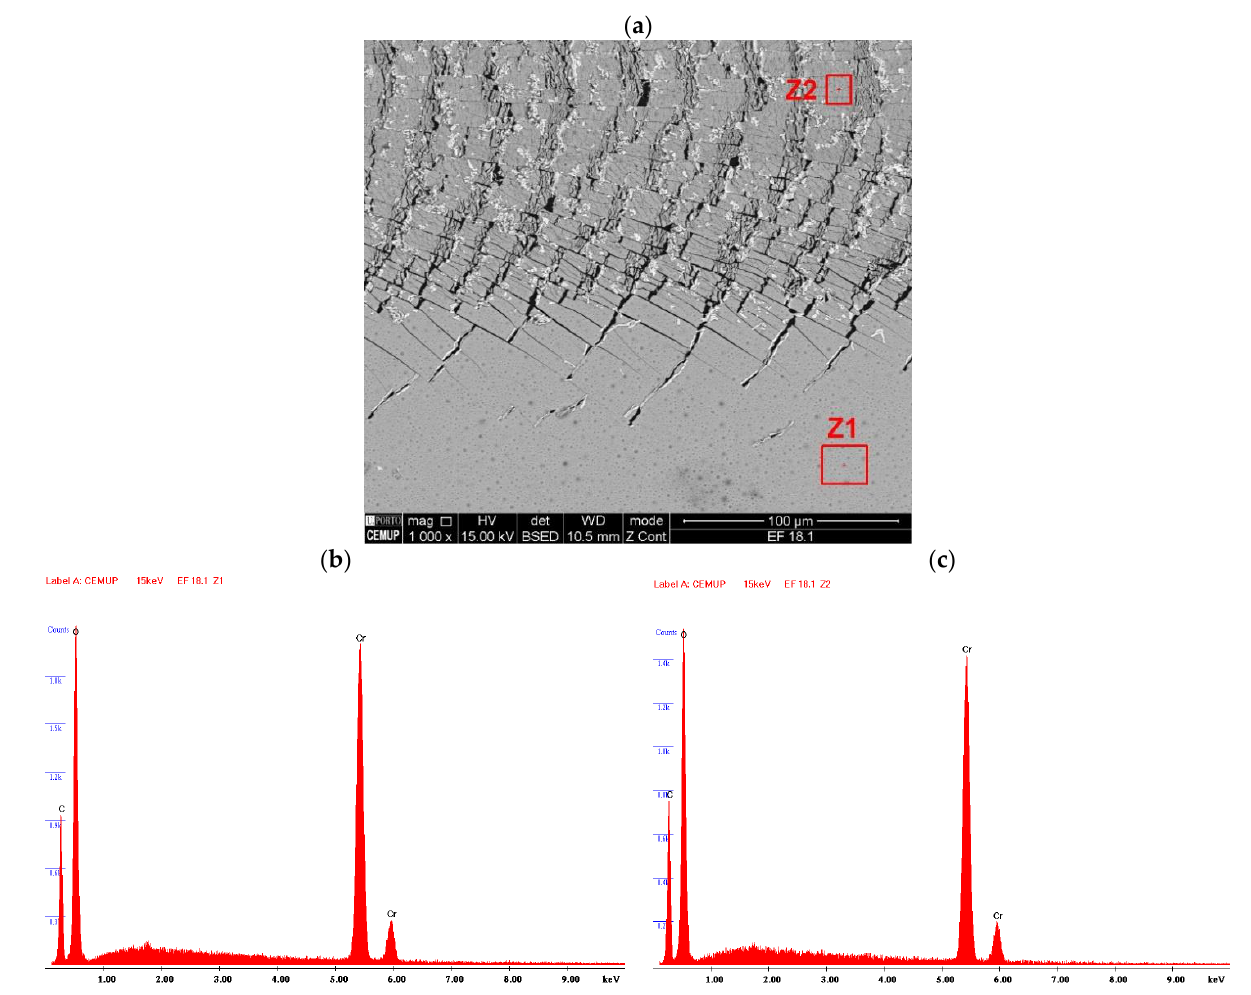
Figure 9. Energy dispersive spectroscopy (EDS) analysis of a scratch groove with ( a ) a partial groove view of a 10 layers coating, ( b ) spectrum of the external scratch area (Z1), and ( c ) internal scratch area (Z2).